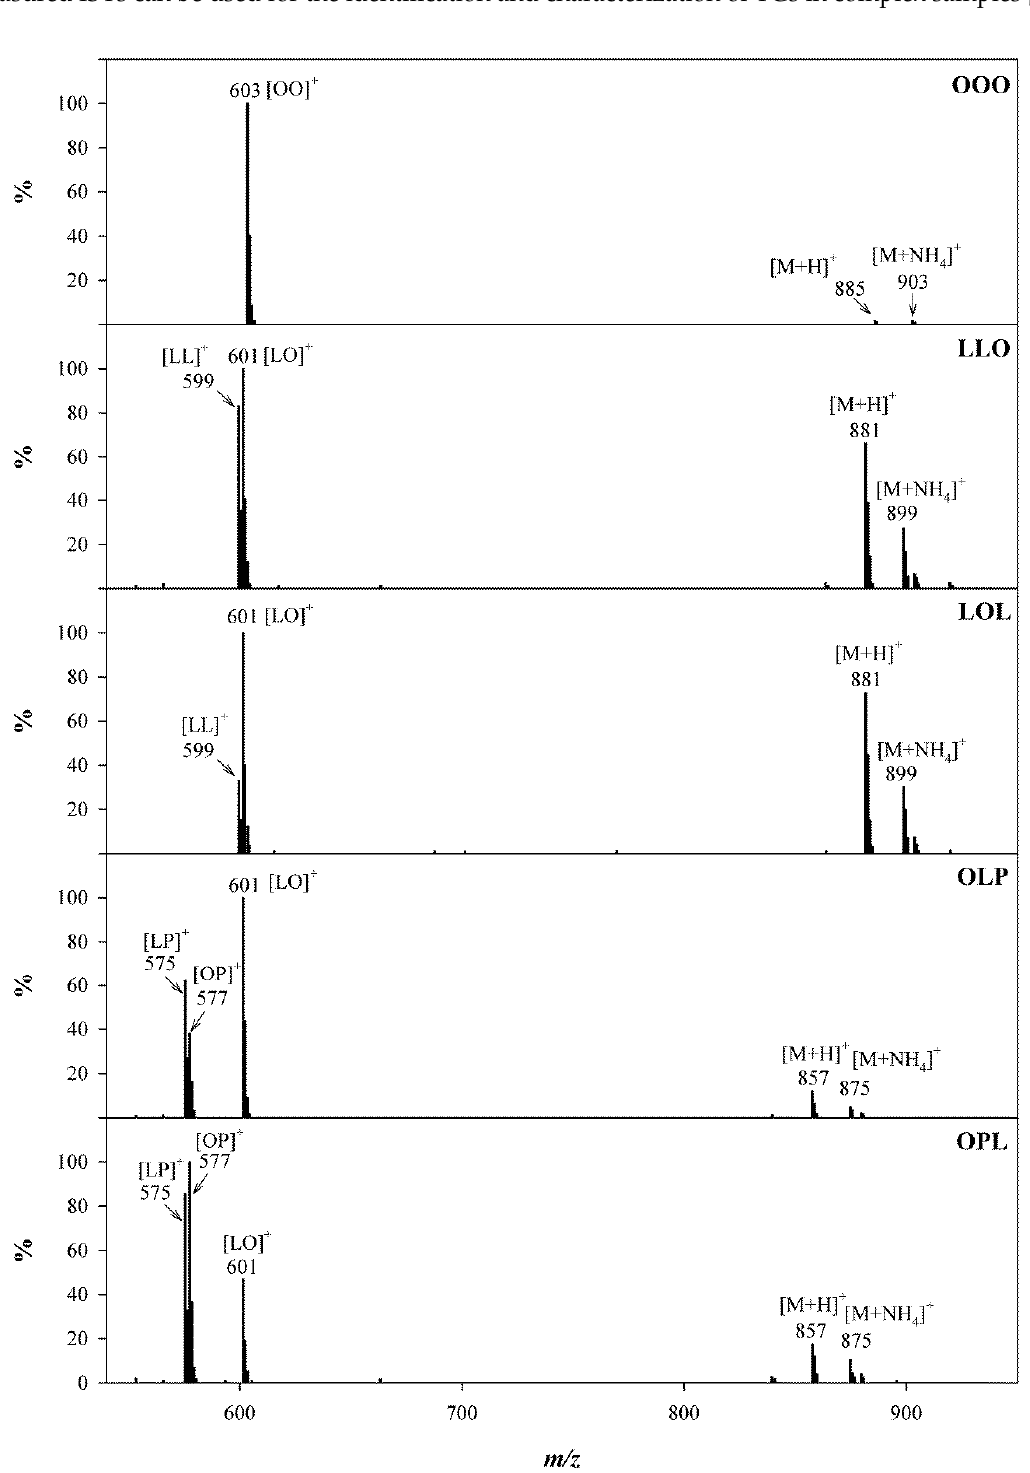
Figure 3. Positive ion ESI spectra of TGs containing different acyls on the glycerol backbone. OOO, LLO and LOL, and OLP and OPL were used as representative examples for single-acid type (R 1 R 1 R 1 ), mixed-acid type (R 1 R 2 R 1 or R 1 R 1 R 2 ) and mixed-acid type (R 1 R 2 R 3 ), respectively.